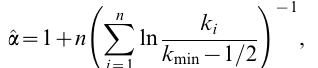
Table 2. Calculation of expected frequencies for pairs of MeSH descriptors.